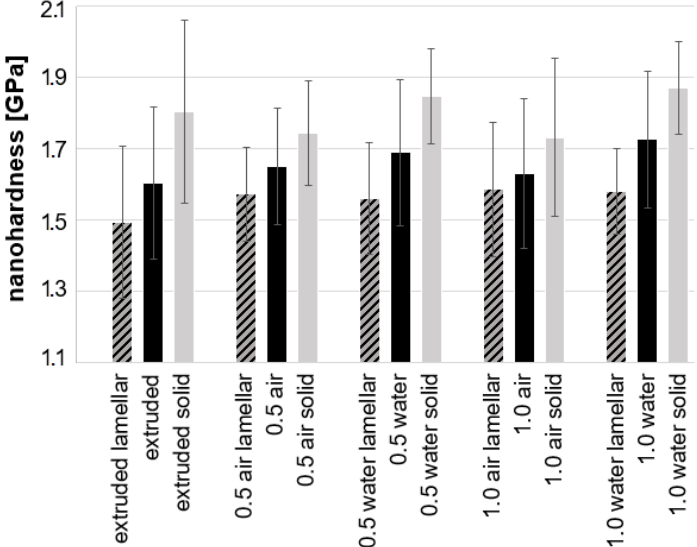
Figure 8. Nanohardness of individual grains clustered to Mg matrix grains with LPSO lamellae and without obvious LPSO lamellae (solid) compared to overall hardness—given solution heat treatment and cooled in air and water quenched (numbers stand for heat treatment duration).